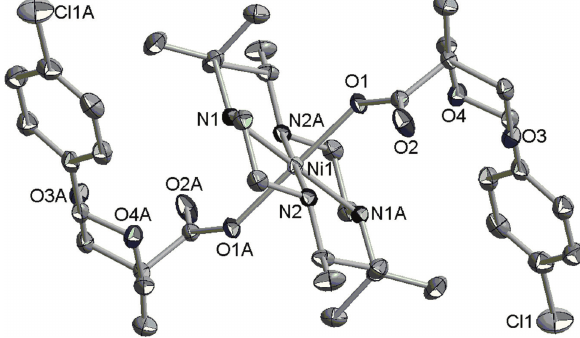
Table 1: Data collection and handling.